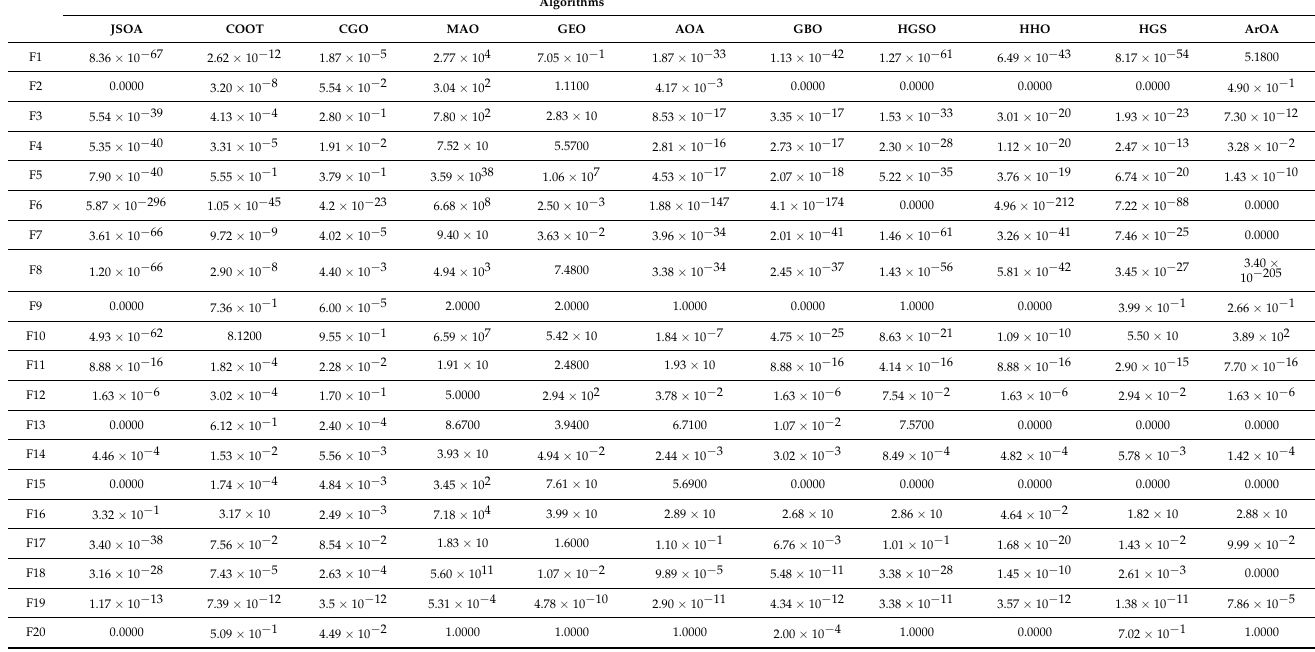
Table 4. Error rates results (20 benchmark